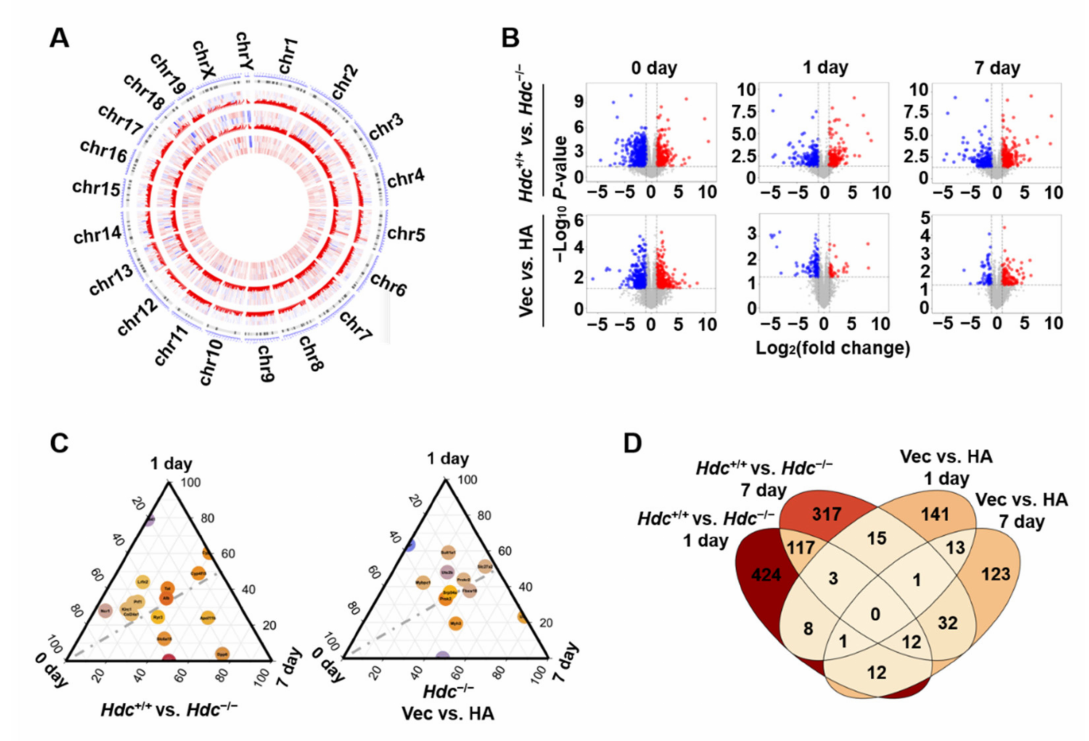
Figure 2. The gene expression profiling of the mice in each group. ( A ) Circos heatmap of differentially expressed genes. DEGs are present in the order of chromosomes. The bigger circles represent the DEGs at day 0, 1, and 7 after MI. The smaller circles compare the expressions of DEGs among Hdc +/+ , Hdc − / − , and Hdc − / − with histamine treatment. ( B ) Volcano plots display DEGs with Hdc deficiency or histamine treatment at day 0, 1, and 7 after MI. Transcripts up-or down-regulated are in red or blue and those unchanged are in gray. ( C ) Venn diagram of DEGs overlapping at different experimental time points and under different treatments. ( D ) Triangle pictures show the expression of DEGs at day 0, 1, and 7 after MI, comparing Hdc +/+ vs. Hdc − / − ( left ), and Vec vs. HA ( right